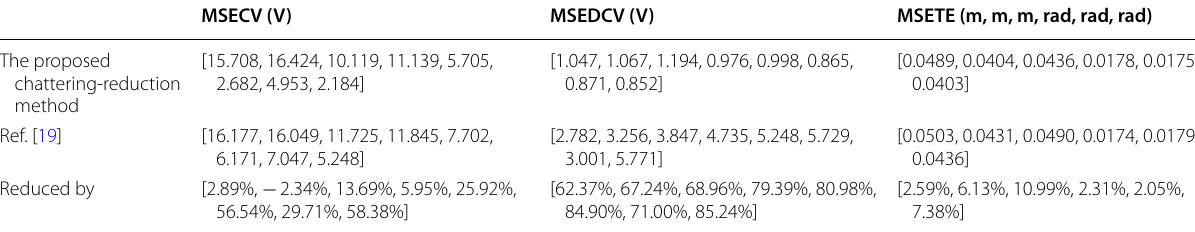
Table 5 The chattering simulation experimental data